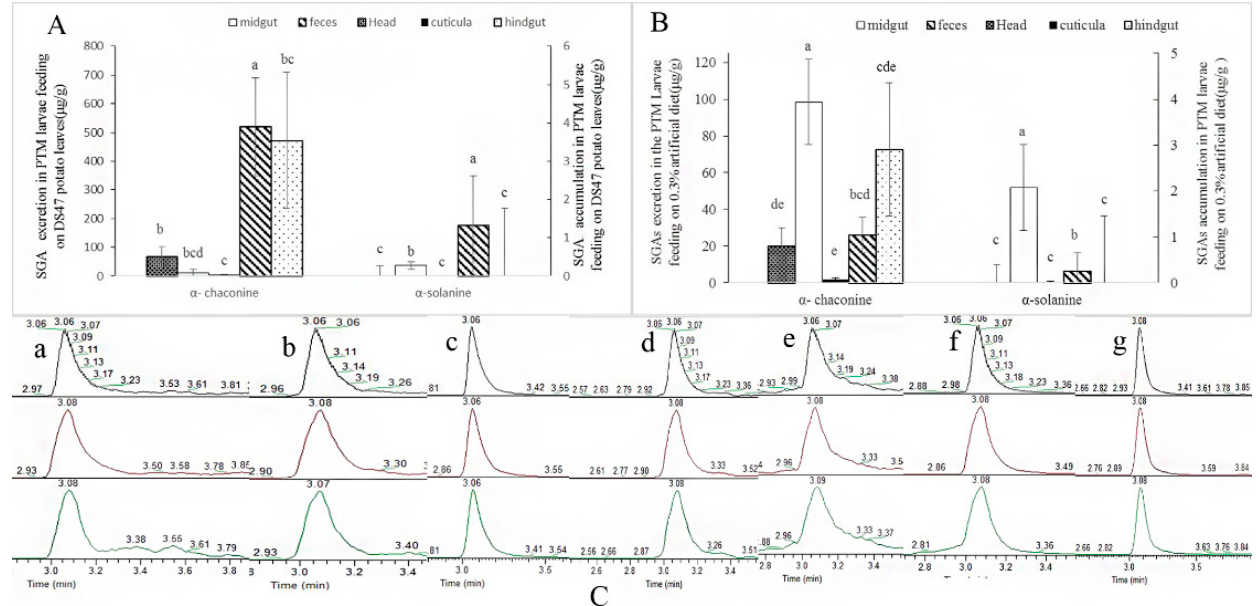
Figure 2. SGA accumulation and excretion in potato tuber moth larvae feeding on 0.3% artificial diet and potato leaves (( A ), artificial diet feeding; ( B ), DS47 leaf feeding; ( C ), total ion current (TIC) and extract ion (EI) profiles at 852.70 m / z ([M + H] + ion for α -chaconine) and 868.70 m / z ([M + H] + ion for α -solanine) of the Physorimaea operculella samples: (a) foregut; (b) midgut; (c) hindgut; (d) head; (e) cuticula; (f) feces and exuvia; (g) exuvia).